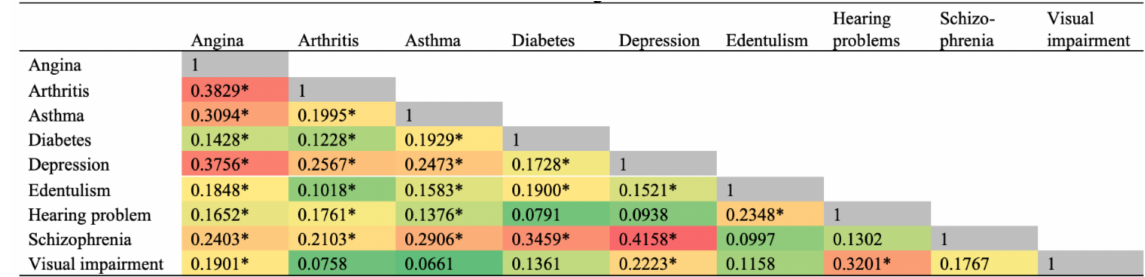
Figure 4. Tetrachoric correlations of non-communicable diseases among individuals with tuberculosis. * p < 0.05.